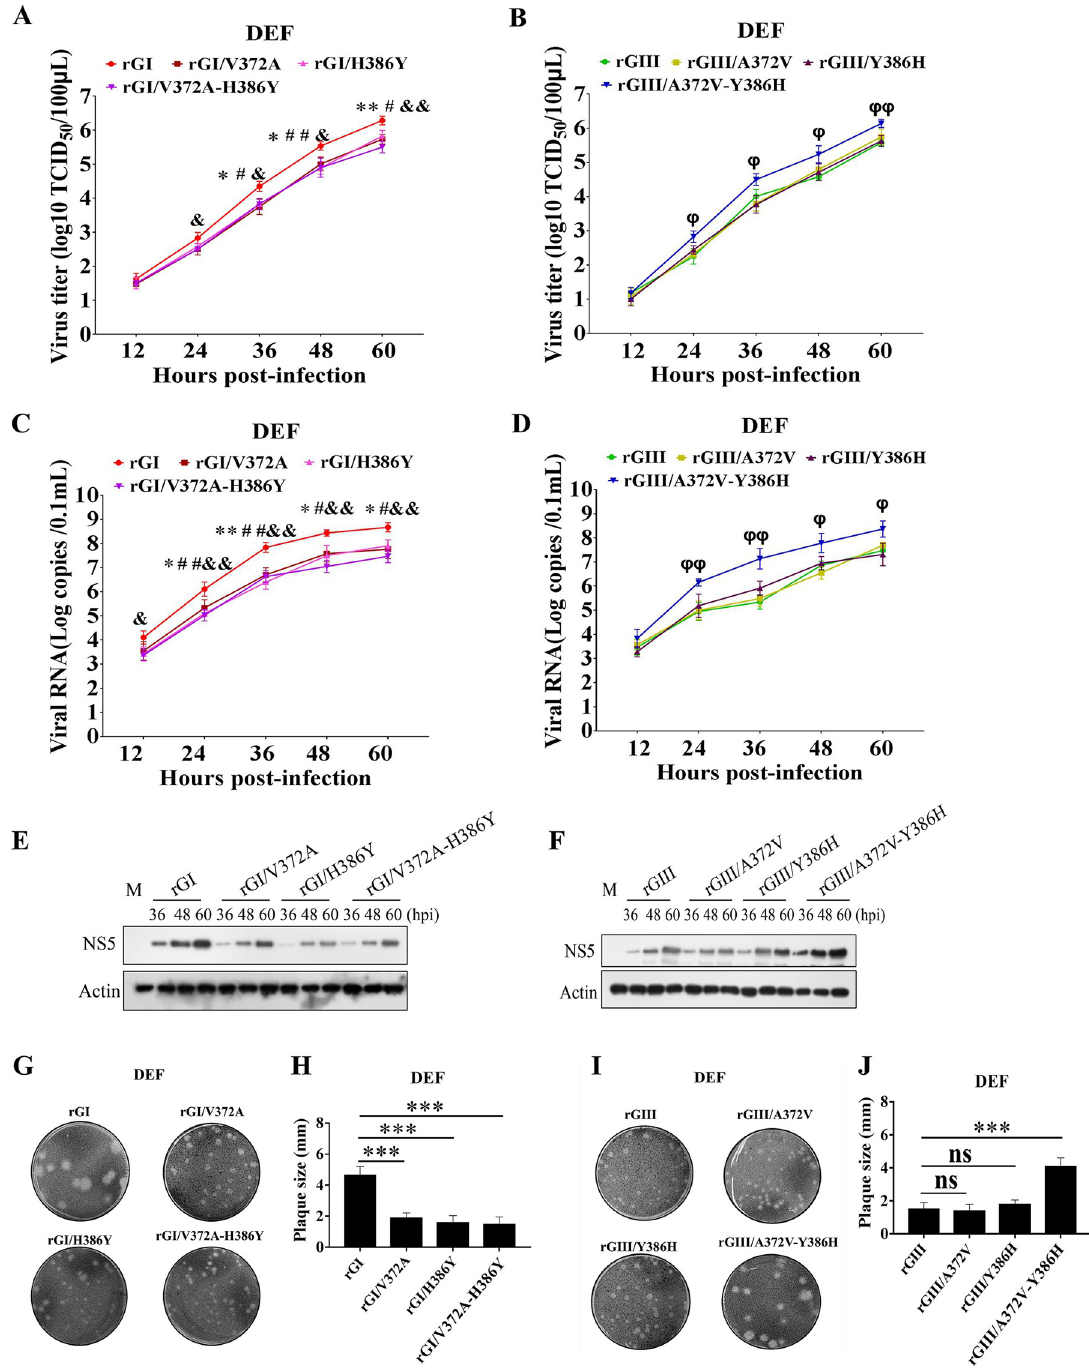
Fig 8. Effects of NS5-V372A and NS5-H386Y variations on viral replication. (A to F) DEF were infected with the indicated substitution mutant viruses at 0.01 MOI and collected at the indicated time points for analysis of replication efficiency. The replication titers in the supernatants were titrated with TCID 50 assays in BHK cells (A and B). The viral RNA copies and NS5 protein levels in the cells were examined with TaqMan probe-based qRT-PCR (C and D) and western blotting with anti-NS5 antibodies (E and F), respectively. All data are presented as mean ± SD from three independent experiments and were tested by Student’s t -test. The significant difference between rGI and rGI/V372A is labeled ( �� , p < 0.01; � , p < 0.05). The significant difference between rGI and rGI/ H386Y is marked (##, p < 0.01; #, p < 0.05). The significant difference between rGI and rGI/V372A-H386Y is indicated (&&, p < 0.01; &, p < 0.05). The significant difference between rGIII and rGIII/A372V-Y386H is indicated ( φφ , p < 0.01; φ , p < 0.05). (G to